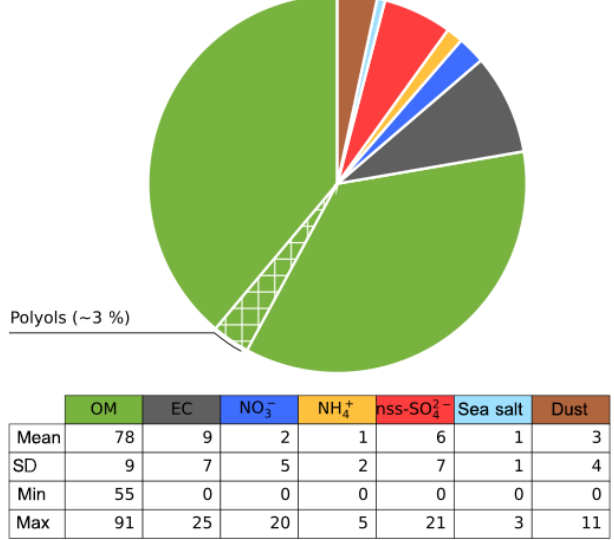
Figure 11. Average contribution (%) of species in the PBOA factor for the sites in SOURCES and DECOMBIO. The hatched area rep- resents the proportion of the OM apportioned by the polyols (see text for reconstruction